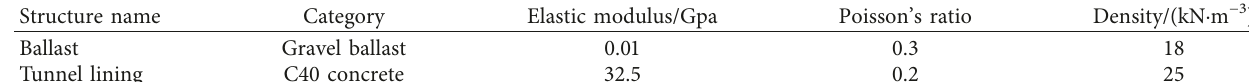
Table 2: Material physical and mechanical parameters table.